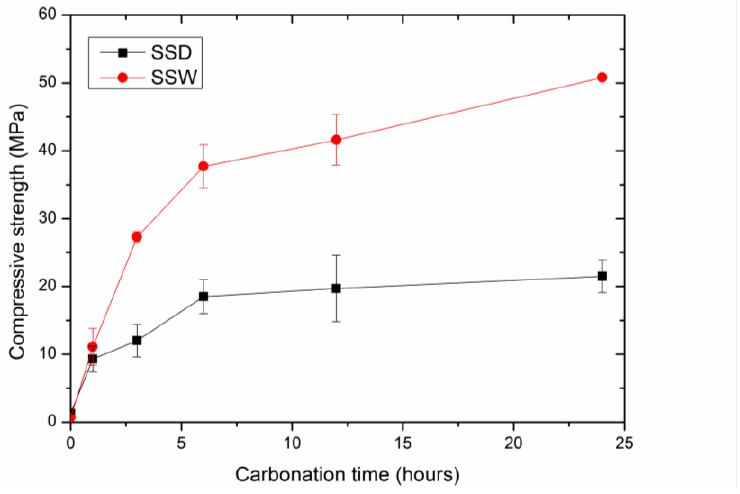
Figure 4. The effect of carbonation time on the compressive strength of the compacts made from SSD and SSW.